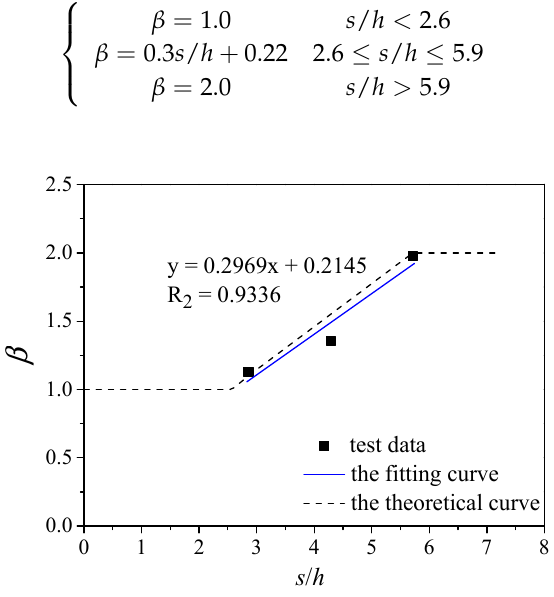
Figure 8. The relationship between β and s / h .